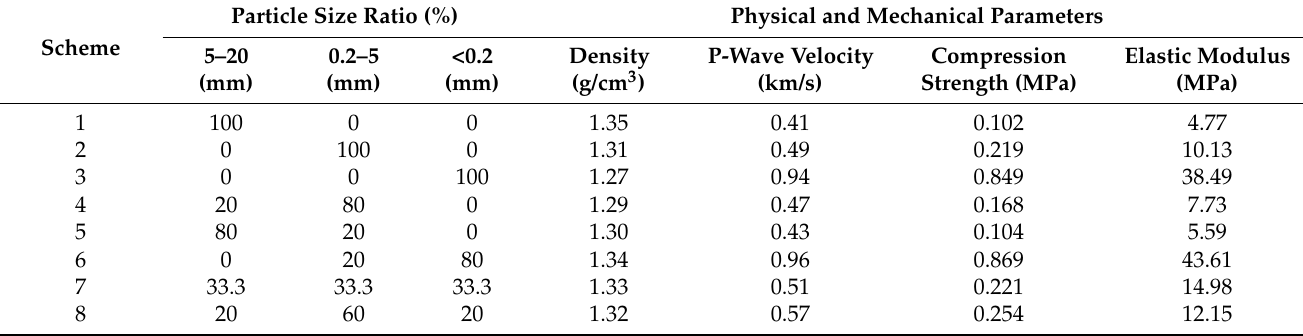
Table 2. The physico-mechanical parameters of reconstituted coal sample with various particle size distribution.